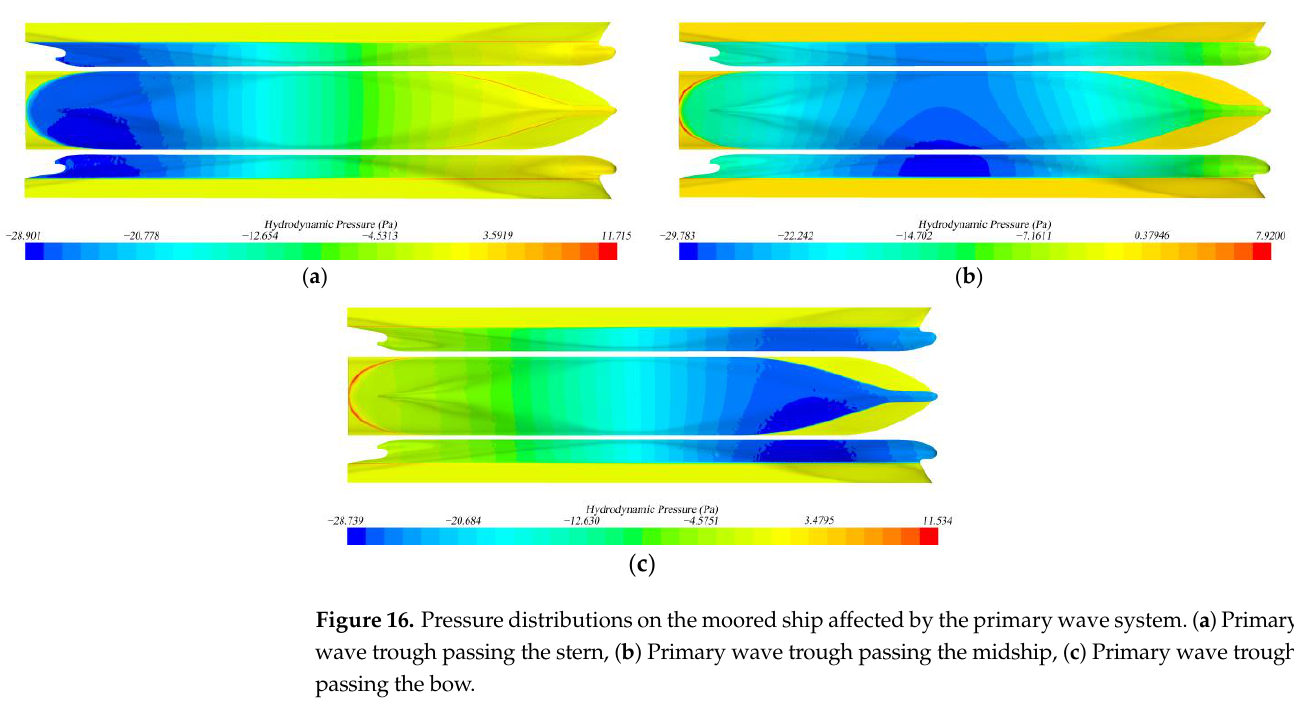
Figure 15. Pressure distributions on the moored ship affected by the solitary wave system. ( a ) Soli- tary wave crest passing the stern, ( b ) Solitary wave crest passing the midship, ( c ) Solitary wave crest passing the bow.